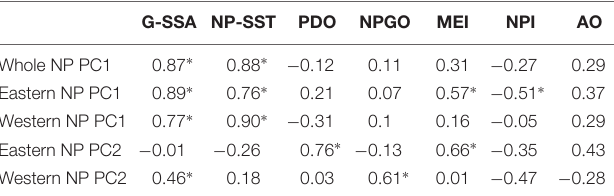
TABLE 2 | Correlations between marine ecosystem PCs and climate indices with 5-year running mean.